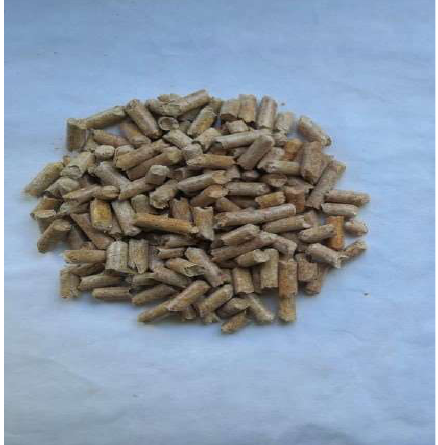
Figure 1. Research